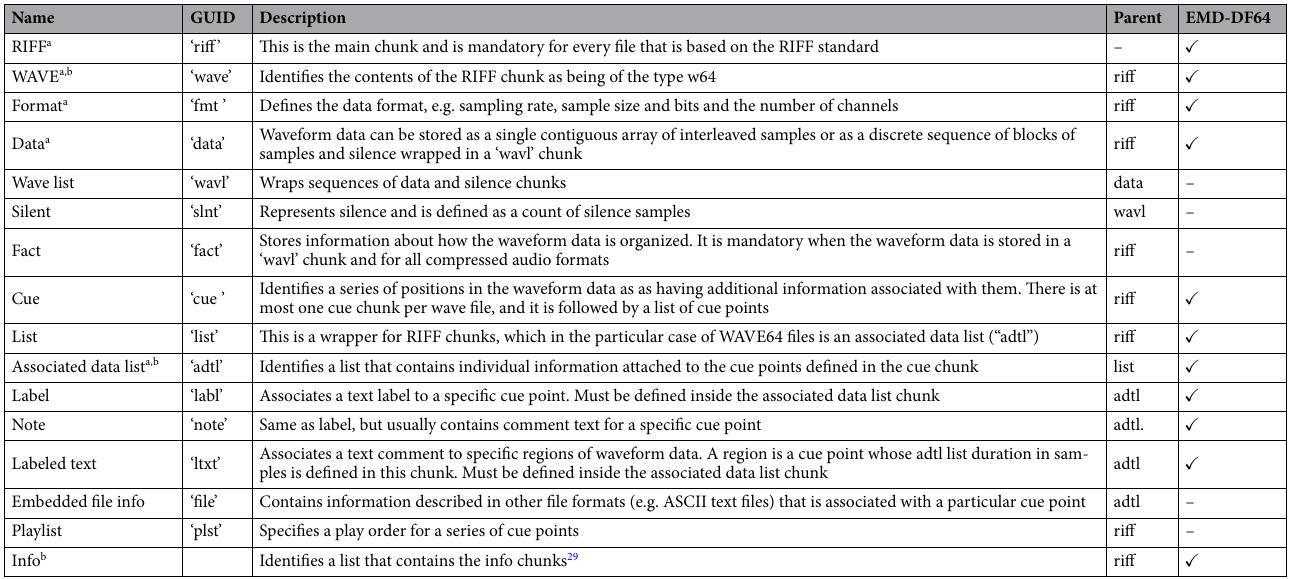
Table 1. List of chunks that compose the RIFF-WAVE64 file format. a These chunks are mandatory. b ‘WAVE’ , ‘adtl and ‘INFO’ are chunk identifiers.